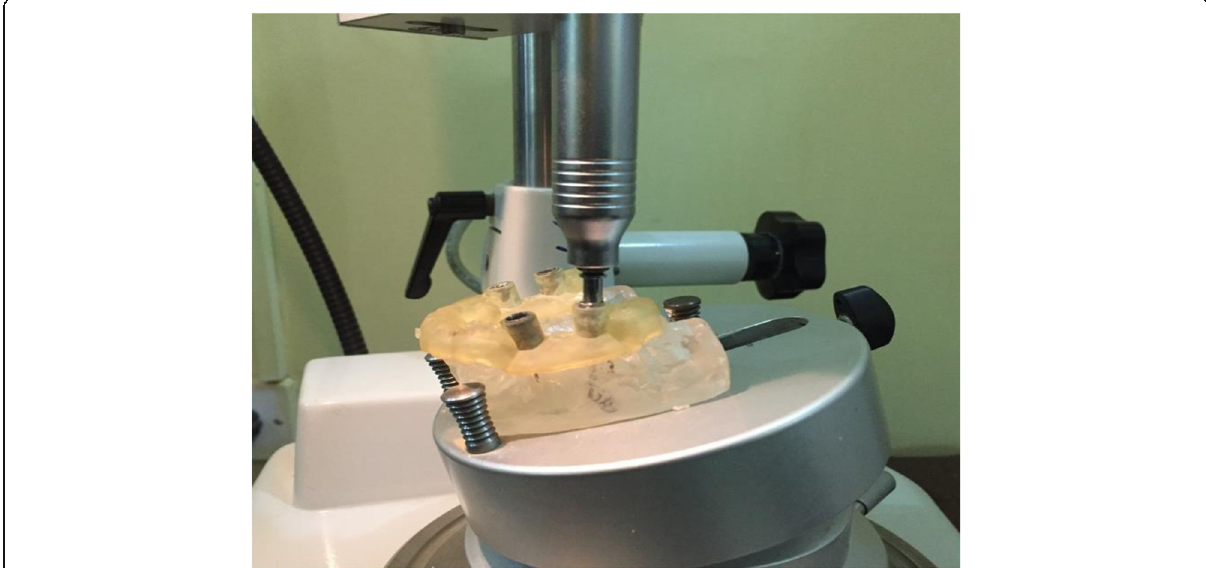
Fig. 2 Dental surveyor for the standardization of drilling, angulations, and implant